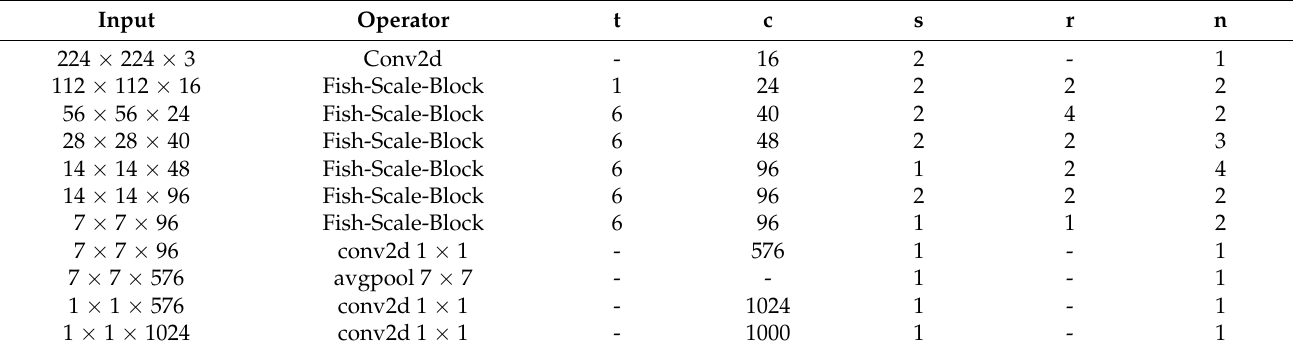
Table 1. Specification for FishScaleNet using MobileNetV3